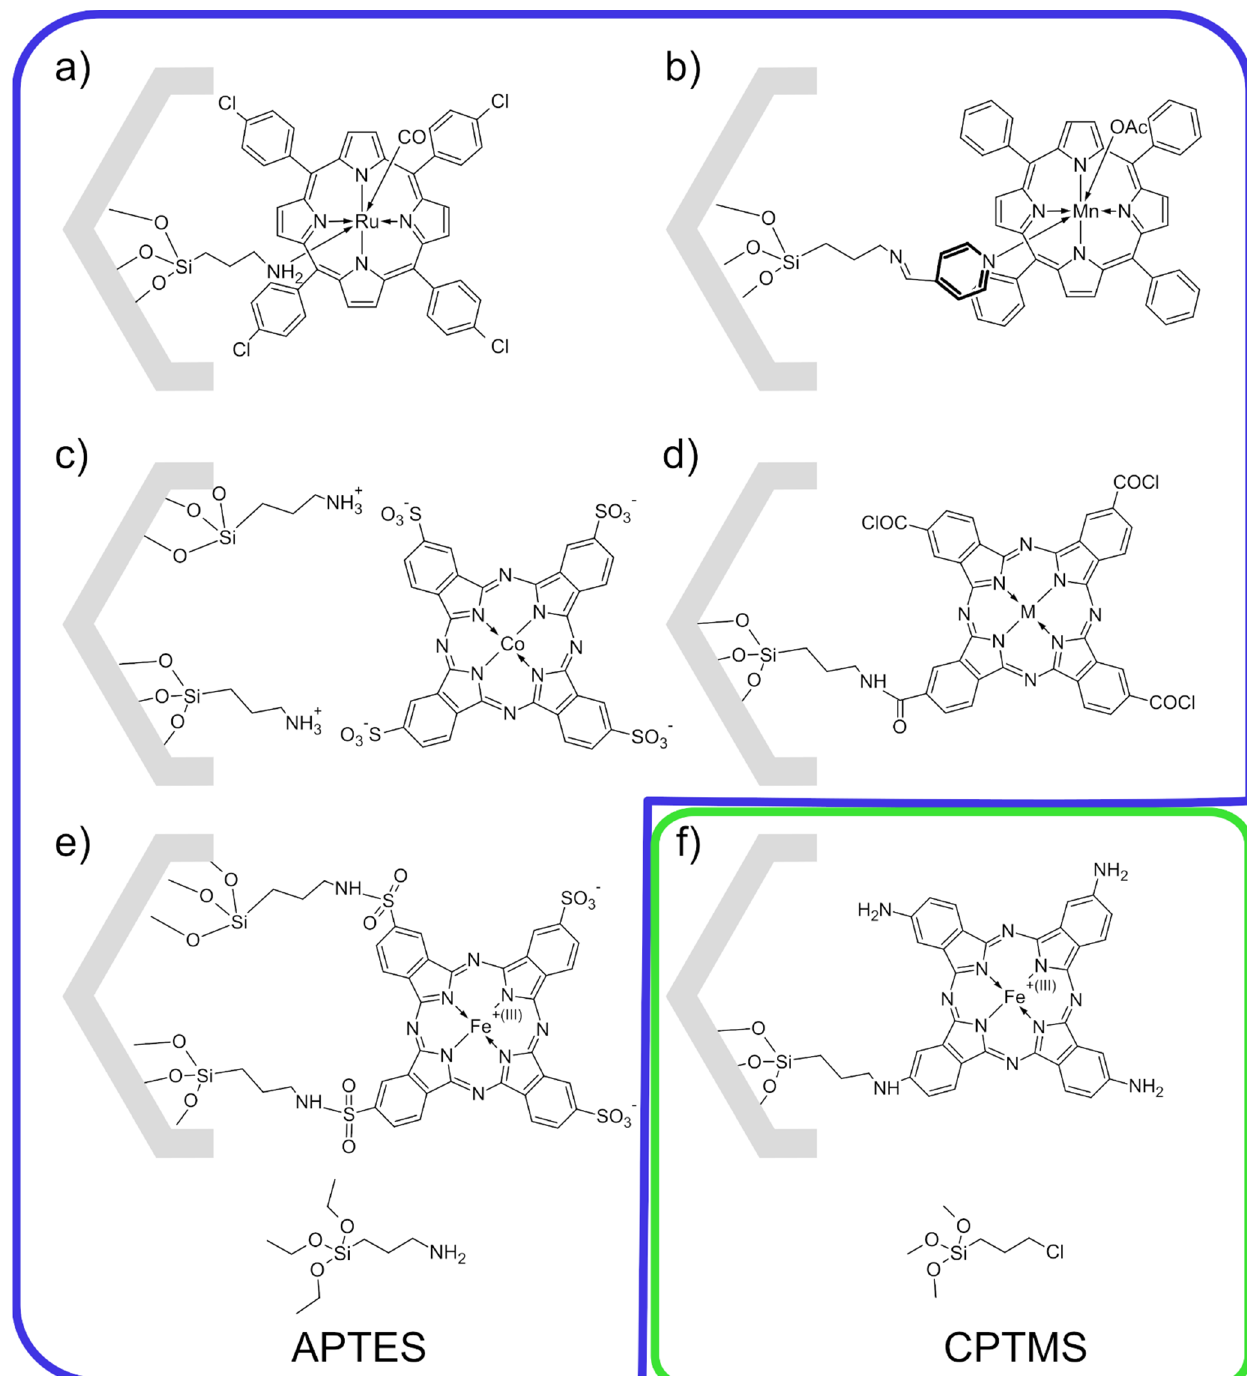
Figure 2. Porphyrins and phthalocyanines incorporated into mesoporous support modified with APTES (3-aminopropyltriethoxysilane)—( a ) [36], ( b ) [39], ( c ) [40], ( d ) [41] (M = 2H, Zn, Cu, Ni, Co, Fe, Mn) and ( e ) [42] and with CPTES (3-chloropropyltriethoxysilane)—( f ) [42]. Ernst and Selle [37] explored three different methods for the immobilization of perfluorinated ruthenium phthalocyanine complexes in the pores of MCM-41: (i) the “ship-in-a-bottle” method, (ii) synthesis method and (iii) grafting the complex onto the functionalized surface of mesoporous material. The first method, “ship-in-a-bottle” (Figure 3a) required introduction of ruthenium carbonyl complex and tetrafluorophthalonitrile into the mesoporous material, subsequent heating of the mixture, followed by extensive